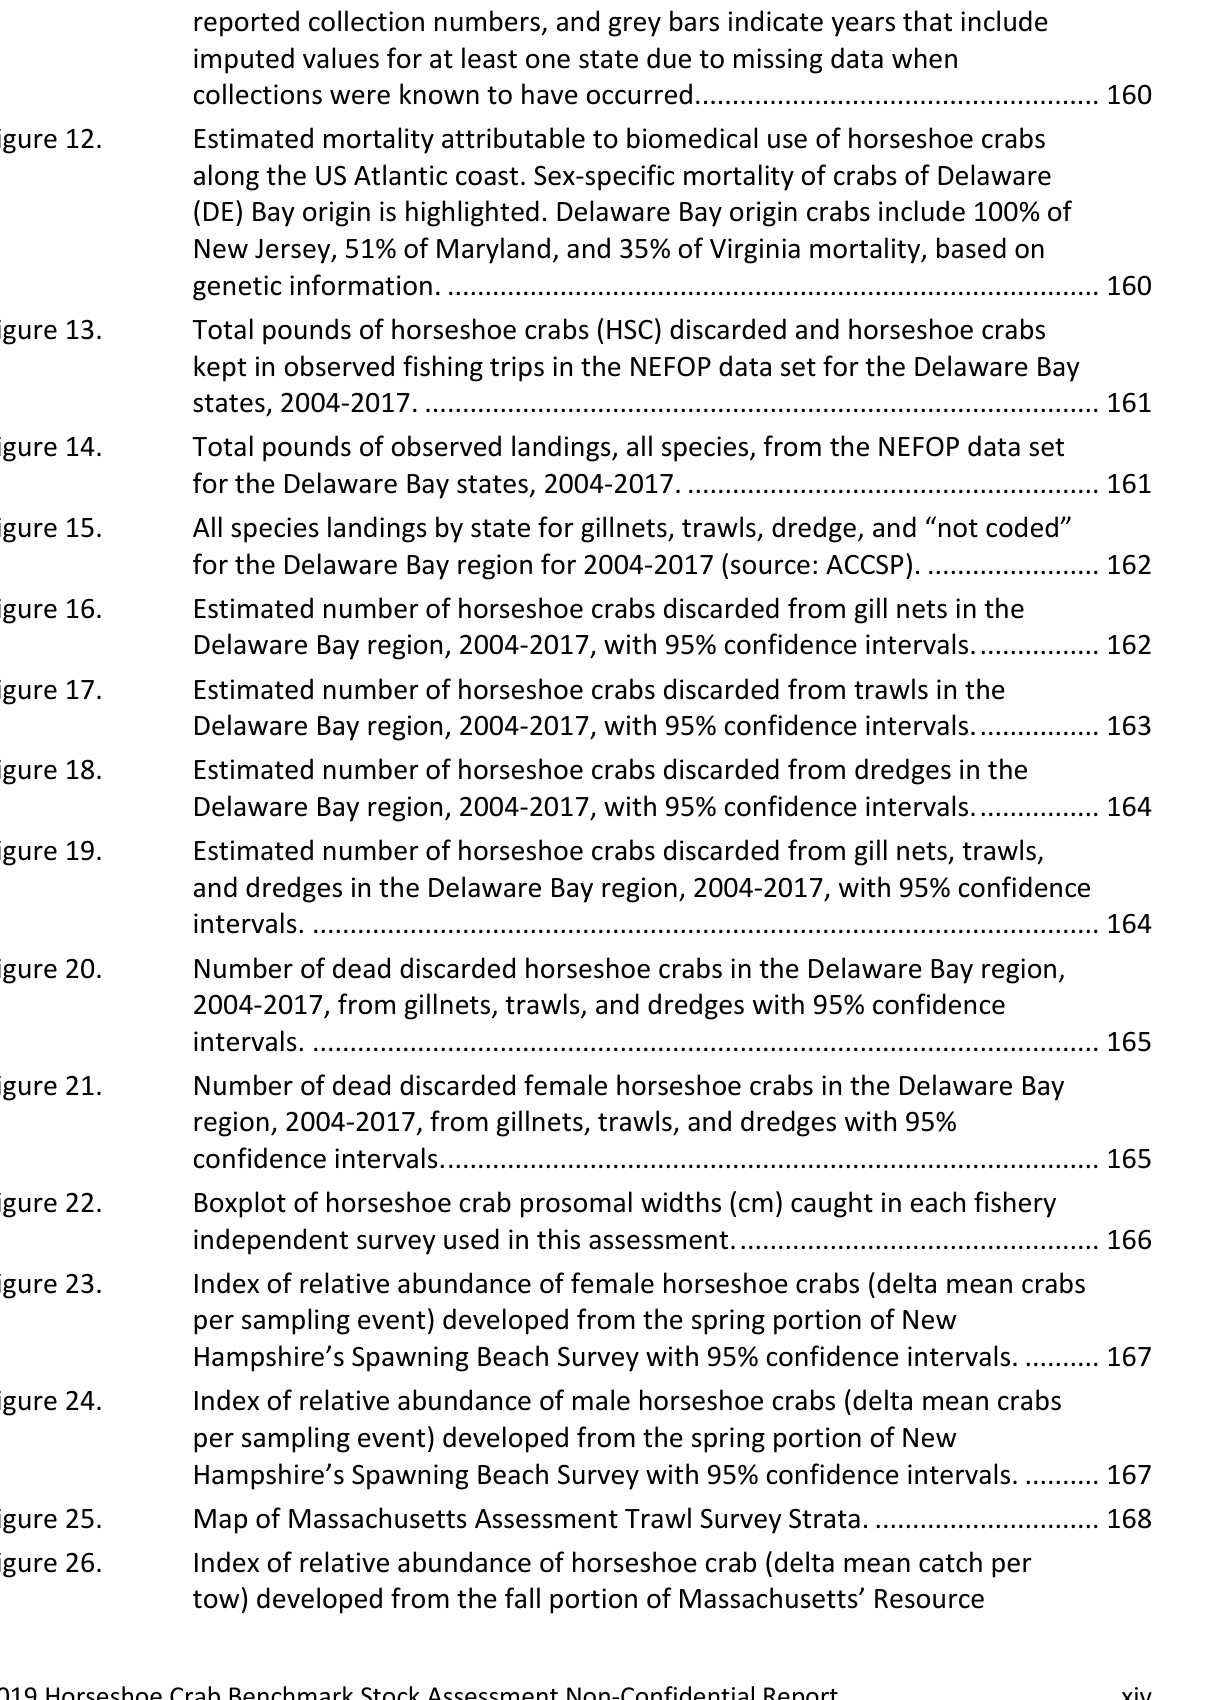
reported collection numbers, and grey bars indicate years that include imputed values for at least one state due to missing data when collections were known to have occurred. ..................................................... 160 Figure 12. Estimated mortality attributable to biomedical use of horseshoe crabs along the US Atlantic coast. Sex-specific mortality of crabs of Delaware (DE) Bay origin is highlighted. Delaware Bay origin crabs include 100% of New Jersey, 51% of Maryland, and 35% of Virginia mortality, based on genetic information. ....................................................................................... 160 Figure 13. Total pounds of horseshoe crabs (HSC) discarded and horseshoe crabs kept in observed fishing trips in the NEFOP data set for the Delaware Bay states, 2004-2017. .......................................................................................... 161 Figure 14. Total pounds of observed landings, all species, from the NEFOP data set for the Delaware Bay states, 2004-2017. ....................................................... 161 Figure 15. All species landings by state for gillnets, trawls, dredge, and “not coded” for the Delaware Bay region for 2004-2017 (source: ACCSP). ....................... 162 Figure 16. Estimated number of horseshoe crabs discarded from gill nets in the Delaware Bay region, 2004-2017, with 95% confidence intervals. ................ 162 Figure 17. Estimated number of horseshoe crabs discarded from trawls in the Delaware Bay region, 2004-2017, with 95% confidence intervals. ................ 163 Figure 18. Estimated number of horseshoe crabs discarded from dredges in the Delaware Bay region, 2004-2017, with 95% confidence intervals. ................ 164 Figure 19. Estimated number of horseshoe crabs discarded from gill nets, trawls, and dredges in the Delaware Bay region, 2004-2017, with 95% confidence Figure 20. Number of dead discarded horseshoe crabs in the Delaware Bay region, 2004-2017, from gillnets, trawls, and dredges with 95% confidence Figure 21. Number of dead discarded female horseshoe crabs in the Delaware Bay region, 2004-2017, from gillnets, trawls, and dredges with 95% Figure 22. Boxplot of horseshoe crab prosomal widths (cm) caught in each fishery independent survey used in this assessment. ................................................ 166 Figure 23. Index of relative abundance of female horseshoe crabs (delta mean crabs per sampling event) developed from the spring portion of New Hampshire’s Spawning Beach Survey with 95% confidence intervals. .......... 167 Figure 24. Index of relative abundance of male horseshoe crabs (delta mean crabs per sampling event) developed from the spring portion of New Hampshire’s Spawning Beach Survey with 95% confidence intervals. .......... 167 Figure 25. Figure 26. Index of relative abundance of horseshoe crab (delta mean catch per tow) developed from the fall portion of Massachusetts’